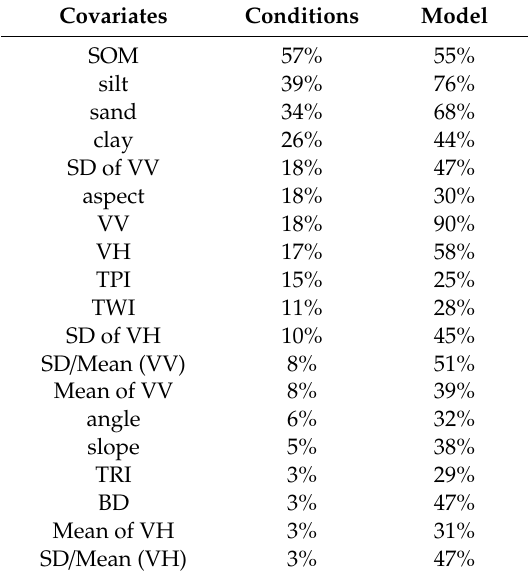
Table 3. Covariates usage in the Cubist model. Abbreviations: VH, backscatter measured in vertical transmit / horizontal receive mode; VV, backscatter measured in vertical transmit / vertical receive mode; Mean and SD of VV and VH refer to the temporal mean and temporal standard deviation values of VV and VH backscatter measurements during 2016–2018; TPI, topographic position index; TRI, terrain ruggedness index; TWI, topographic wetness index; BD, bulk density; SOM, soil organic matter; and LC, land